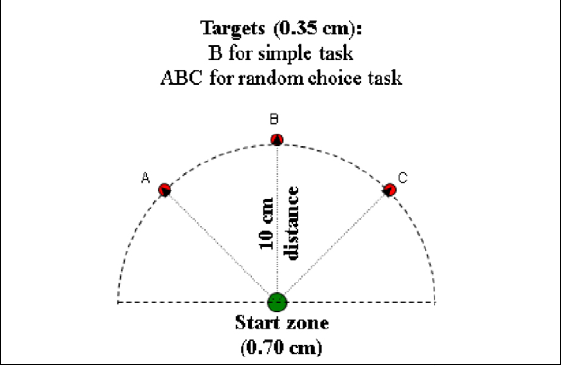
Figure. Illustration of simple and random choice motor tasks According to P. M. Fitts (1954), a movement task difficulty (ID, the “index of difficulty”) can be quantified using information theory metric “bits”. amplitude of movement (10 cm) and W (0.35 cm) is the target width. ID in simple and random choice task was 5.84